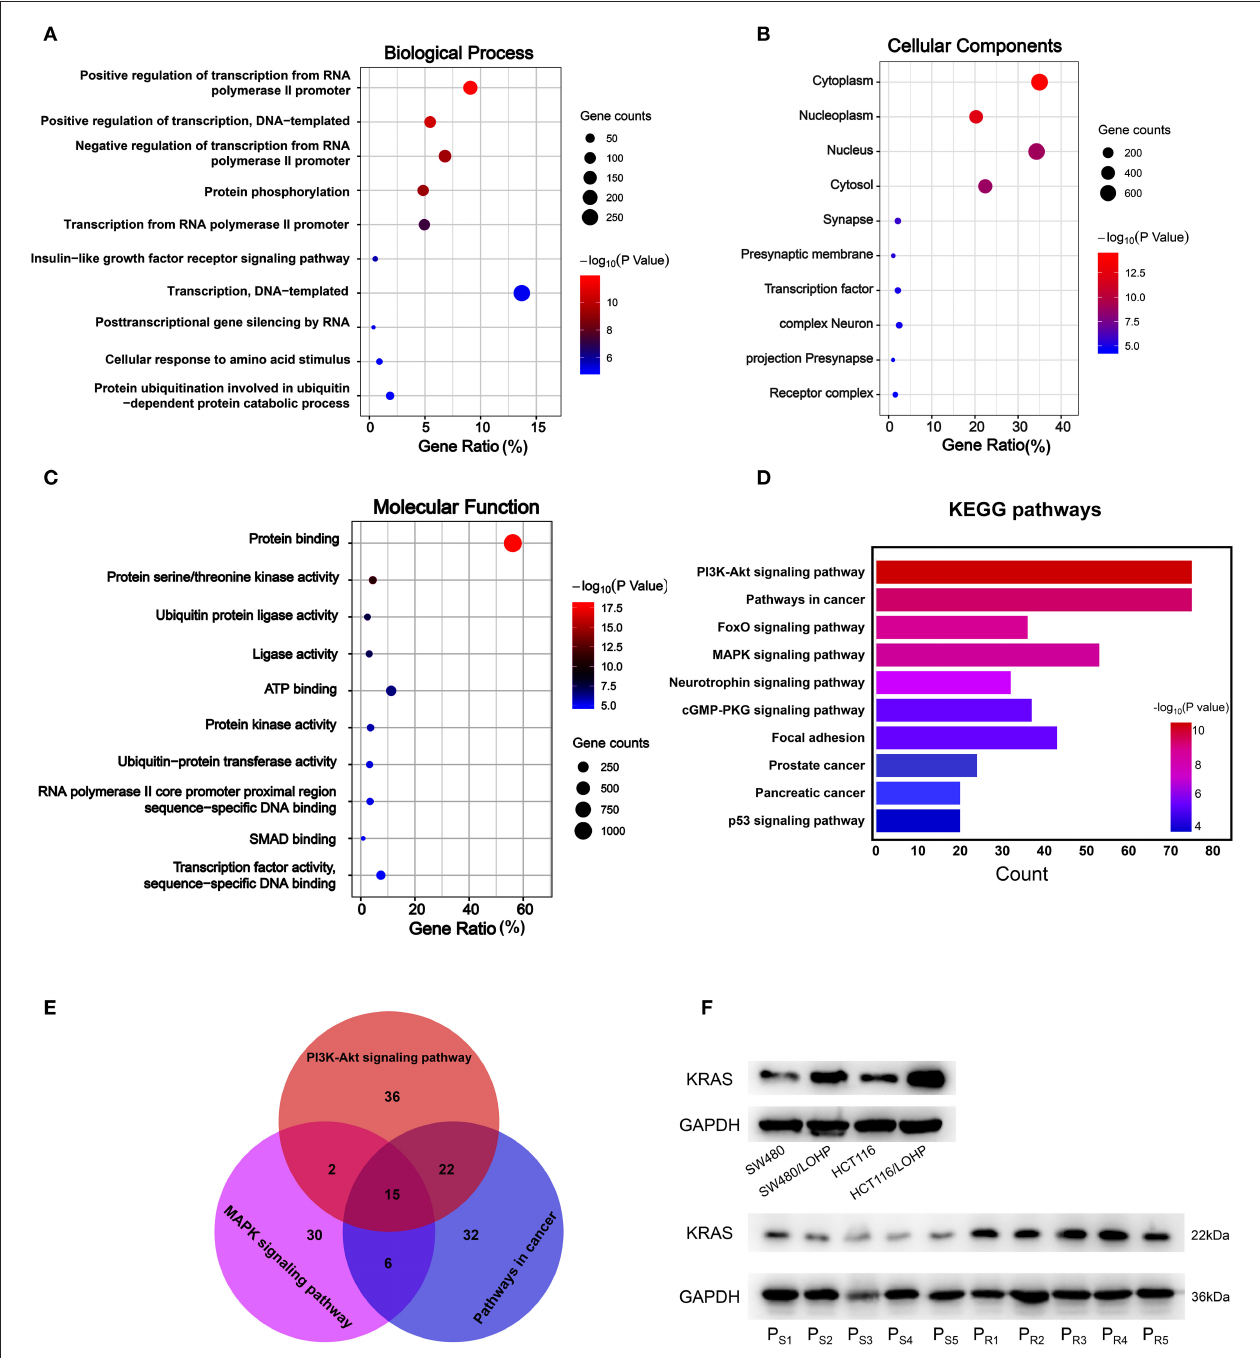
FIGURE 7 | GO and KEGG pathway analyses of downstream target genes of four downregulated miRNAs. (A-C) : GO analysis. (A) Biological processes. (B) Cellular component. (C) Molecular function. (D) The top ten KEGG pathways enriched in the target genes. (E) The analysis of PI3K-Akt signaling pathway, MAPK signaling pathway, and pathways in cancer. (F) The identified target gene KRAS was measured by Western blot in CRC cell lines and tissues. P S : chemosensitive CRC patients. P R : chemoresistant CRC